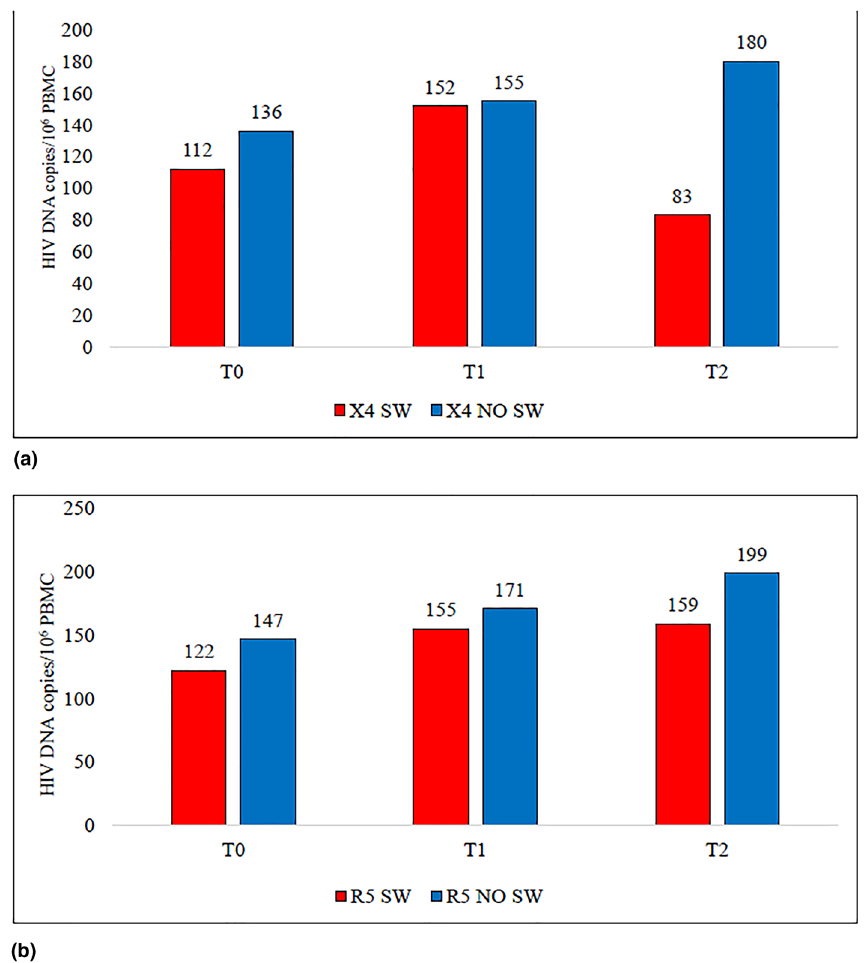
Figure 1. Description of median HIV DNA values (copies/10 6 PBMC) at baseline, T1 and T2 in patients with residual HIV viremia bearing a X4 virus at baseline ( a ) or R5 virus at baseline ( b ) according to the detection or not of tropism switch. PBMC peripheral blood mononuclear cells, T1 week 12 of anti-HCV treatment, T2 week 24 after HCV treatment